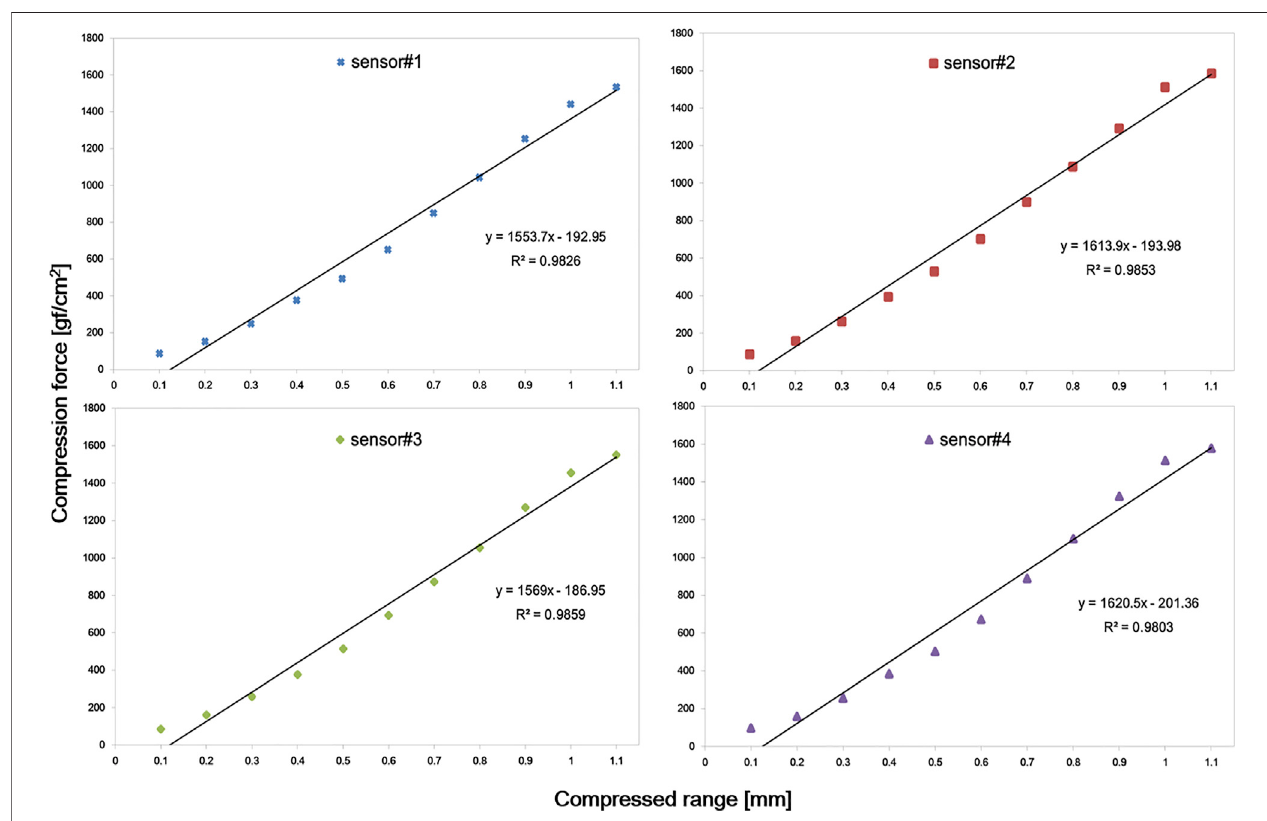
FIGURE 5 | Plot of pressure values according to compression distances. A linear trend was observed in all four sensors within 1 mm compression.